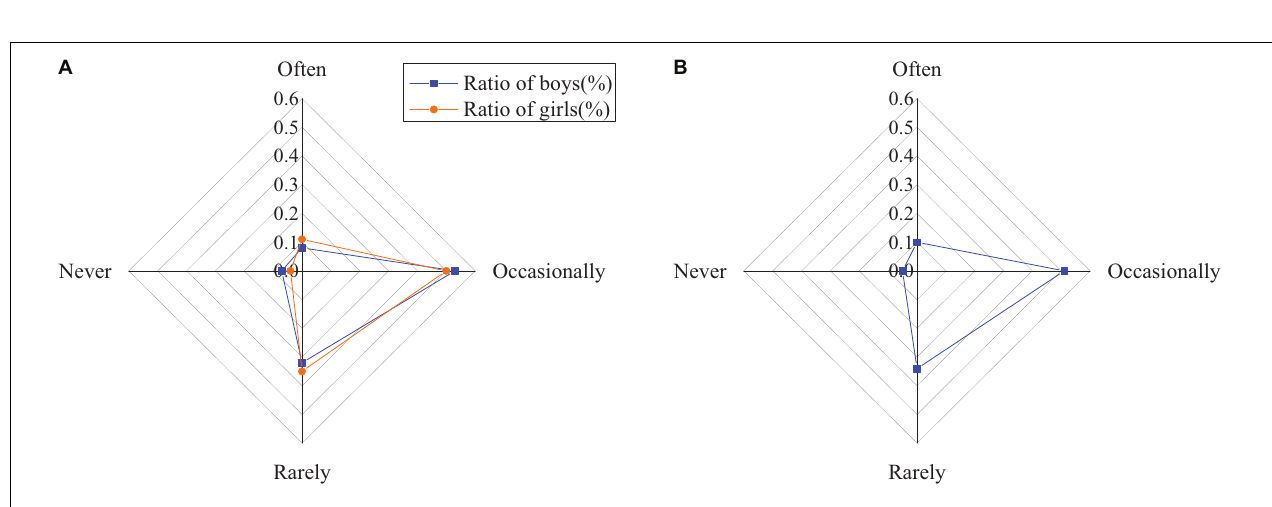
FIGURE 11 | Initiative enthusiasm college students of studying psychological knowledge [ (A) the ratio of males and females; (B) the ratio of all].